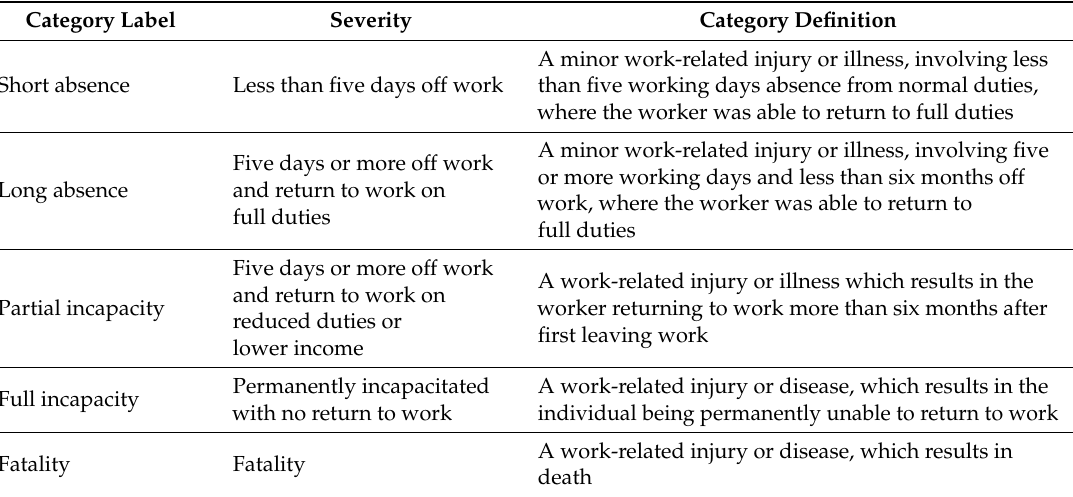
Table 1. Safe Work Australia categories of severity.